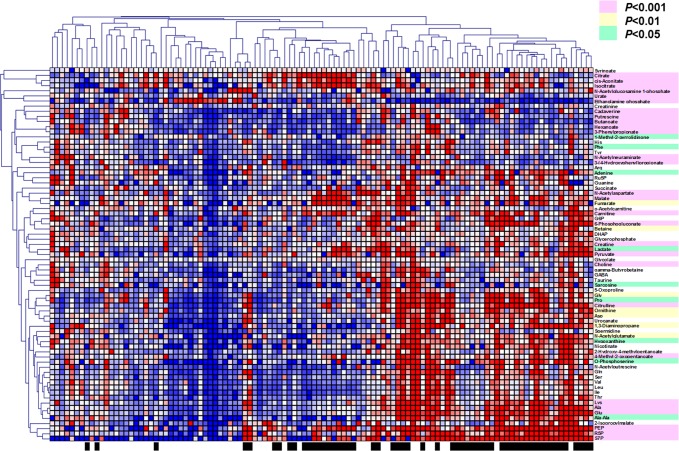
Heat map of salivary metabolite concentrations.Red, white, and blue indicate relatively higher, average and lower concentrations, respectively. Those identified by the black box (bottom of the figure) were from the stimulated saliva samples, and the others were from the unstimulated samples. Clustering was conducted using Pearson correlation. Metabolite names are colored depending on the corrected P-values between the 2 groups.